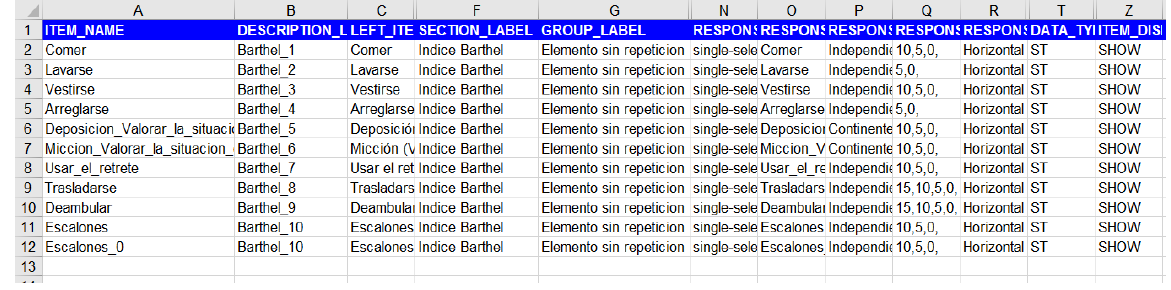
Figure A1. OpenClinica.